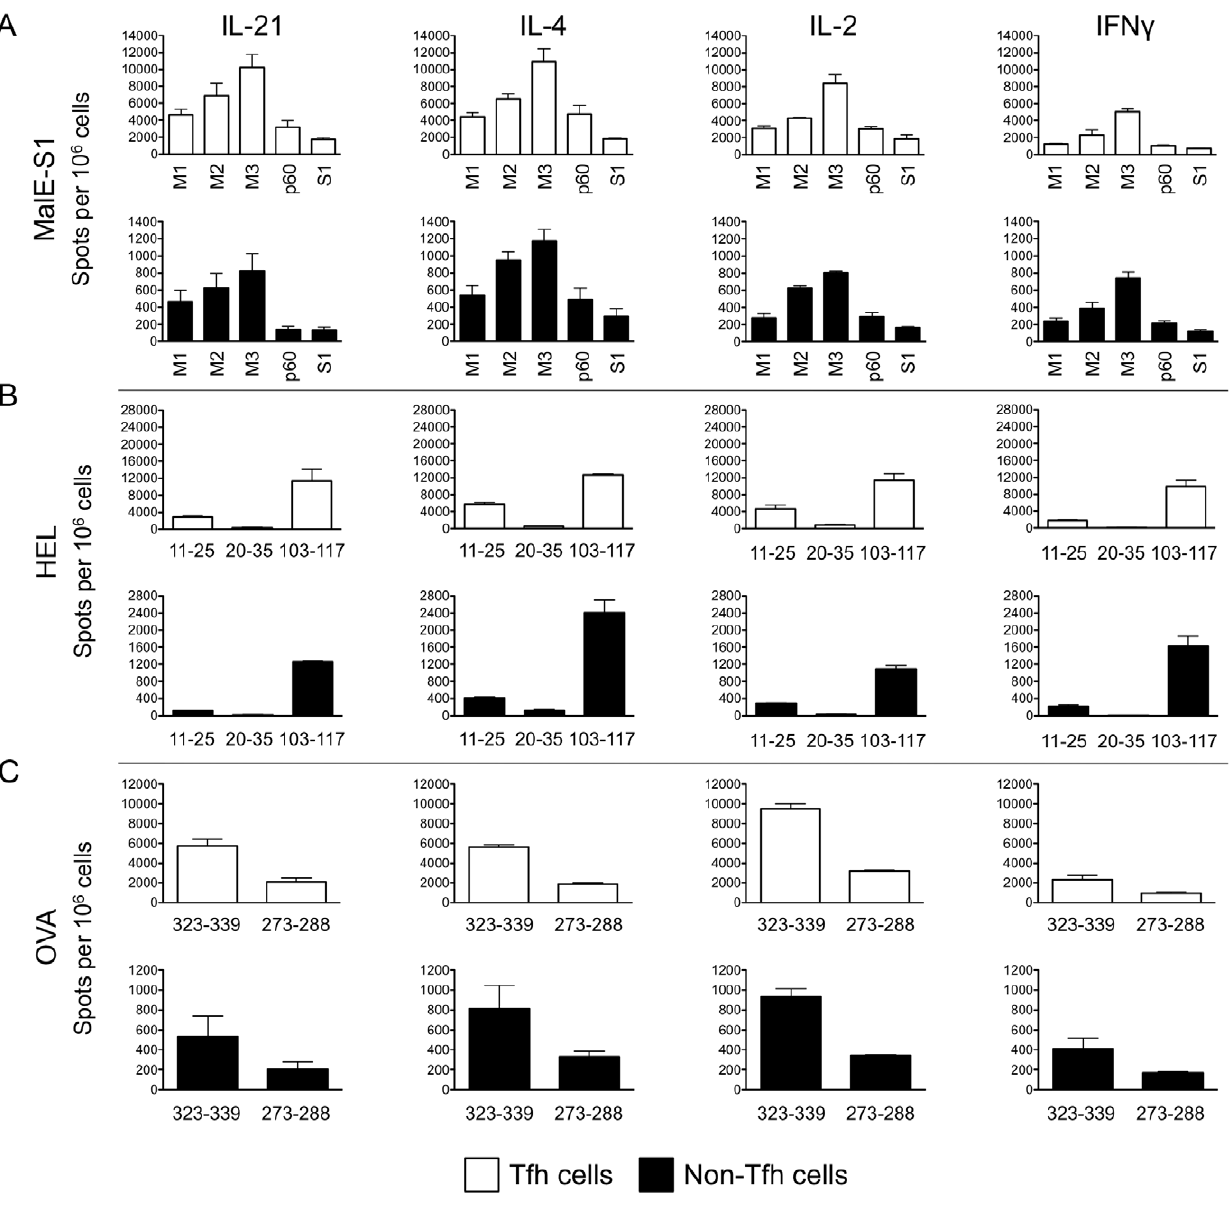
Figure 4. Peptide-specific Tfh responses can be measured with ELISPOT assays. On day 8 or 9 days post-immunization with MalE containing the HA-derived S1 epitope (A), HEL (B), or OVA (C), Tfh and non-Tfh cells were separated and peptide-specific responses were measured with IL-21, IL-4, IL-2 and IFN c ELISPOT assays. The frequency of peptide-specific cytokine-secreting Tfh and non-Tfh cells are shown as cytokine- specific spots per 1,000,000 cells. Open and shaded bars show Tfh and non-Tfh cells respectively. The means of two experiments are shown, with error bars indicating the range.